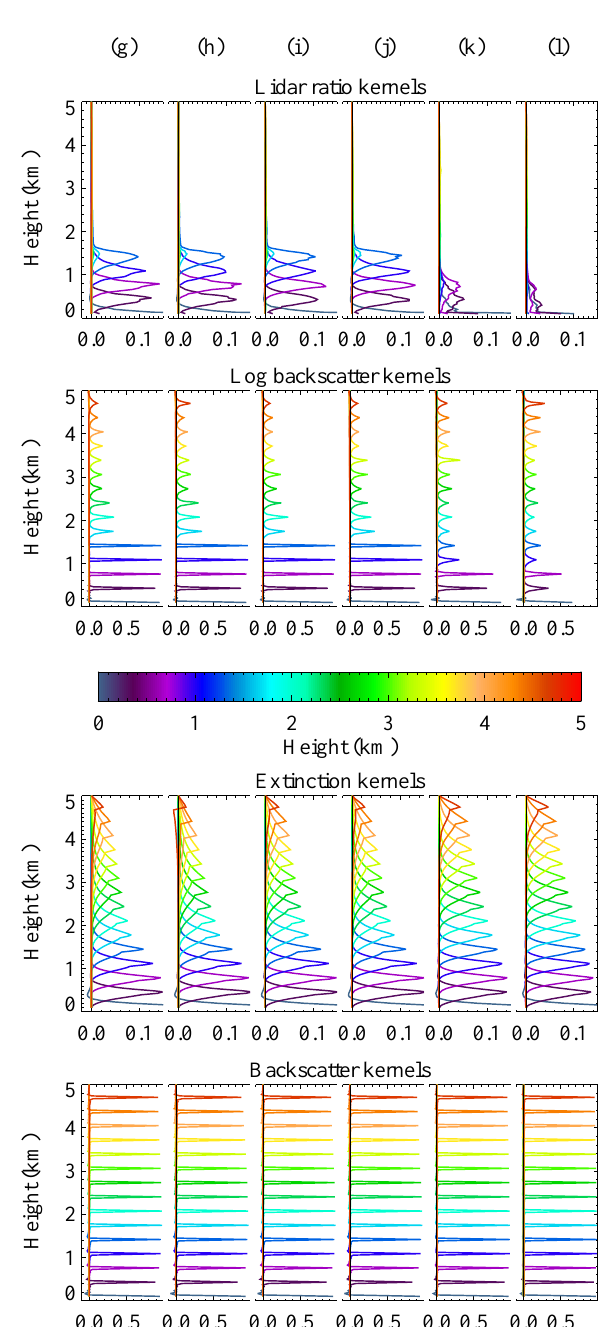
Fig. 7. Selected rows of the averaging kernels for Fig. 5, denoting the relative contribution of the true state at each height ( y axis) to the value retrieved at a height denoted by the colour. Above colour bar – lidar ratio configuration. Below – extinction